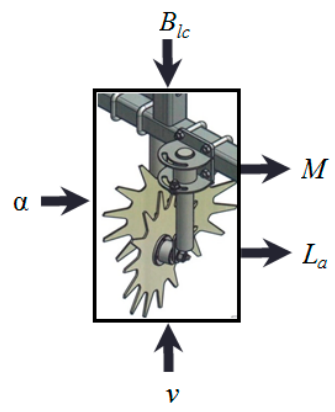
Figure 5. Diagram of multiple regression model of the process of removing plant residue from the strip: B lc —gap between discs, in mm; α —slip angle of row cleaner discs, in degrees; v —driving speed, in m s − 1 ; M —part of plant residue removed from the strip, in %; L a —distance plant residue was moved from the middle of the strip, in